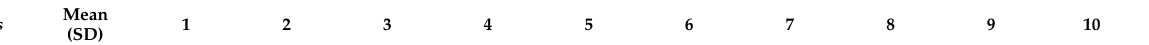
Table 1. Pearson product-moment correlations of SDQ and other variables in the study.